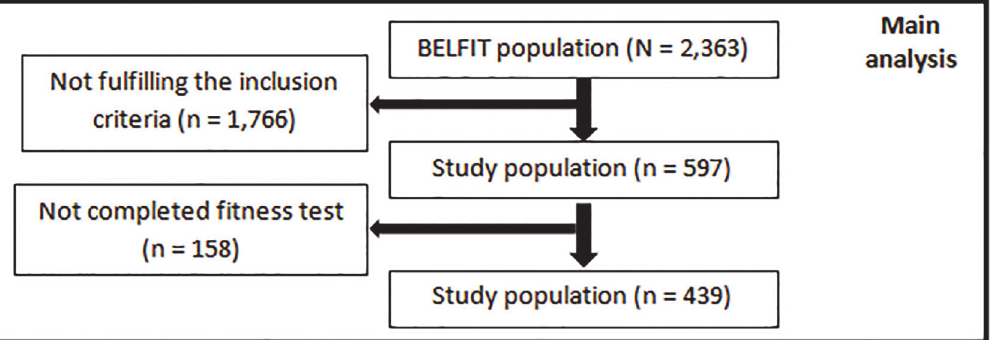
Fig 1. Flow chart of the study population. The complete BELFIT population included 2,363 men. Inclusion criteria for the present study (availability of resting heart rate and diurnal heart rate data from ECG recordings, no history of coronary heart disease and no medical treatment for coronary heart disease or arterial hypertension) reduced the number to 597 participants, with 439 men having completed the exercise test on a bicycle ergometer.